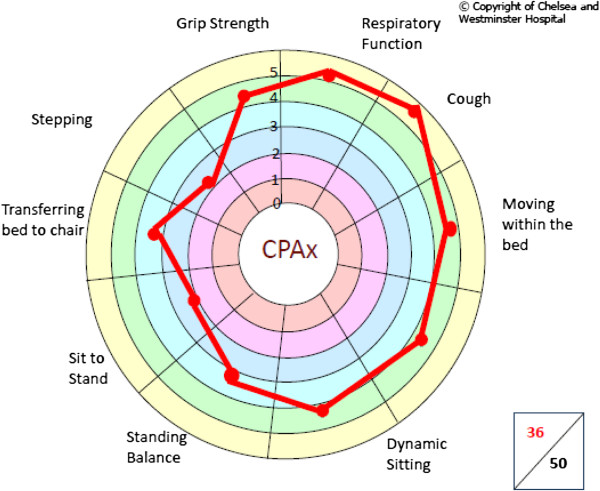
Example of the CPAx radar chart. This image demonstrates that this patient’s respiratory function, cough, and bed mobility are strong, and his rehabilitation should be tailored to work on gait reeducation, and on transferring from bed to chair, and from sit to stand.